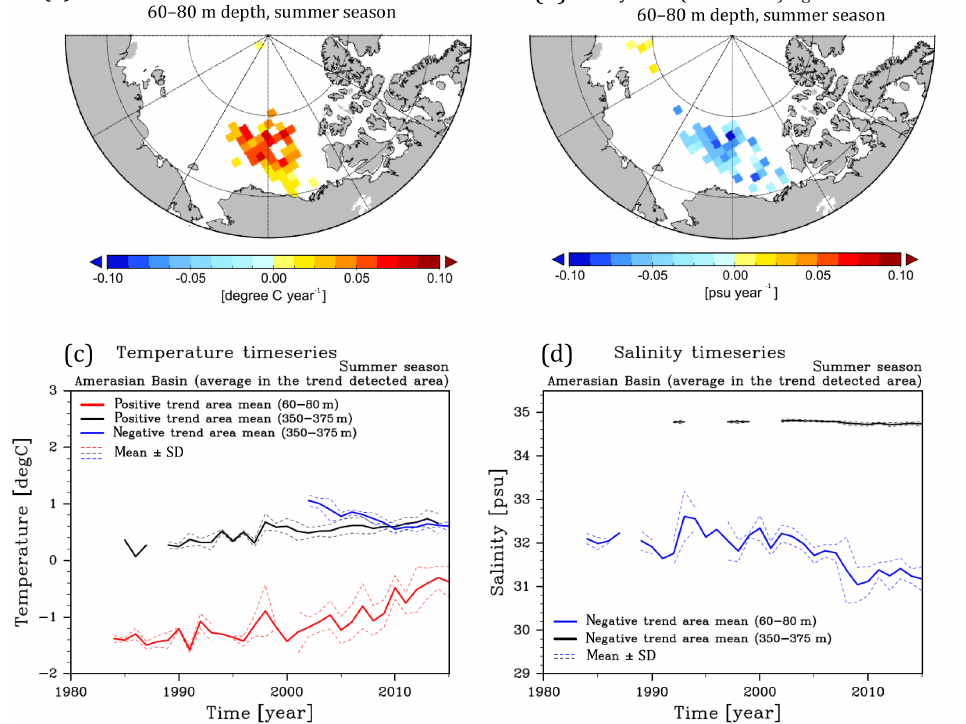
Figure 8. A summary of linear temporal trend in the Amerasian Basin: the spatial pattern of (a) temperature and (b) salinity trend in 60–80m depth range, and the time series of averaged (c) temperature and (d) salinity over the grid cells where a trend is detected in the Amerasian Basin. The trend is calculated in each 111km × 111km grid cell for the period covered by data, and the Mann–Kendall rank statistic (Kendal, 1938) is applied to test the significance. In panels (a) and (b) , only the grid cells, the trends of which are statistically significant (significance level 5%), are shown in color. Time series of averaged temperature/salinity over the corresponding area are shown in panels (c) and (d) by the thick-solid lines. Black thick-solid lines in panels (c) and (d) exhibit averages over the grid cells, where positive (negative) trends of T ( S) are detected along the southern perimeter of the Canada Basin in the 350–375m depth range (spatial pattern is not shown). The dashed lines in panels (c, d) depict the range of 1 standard